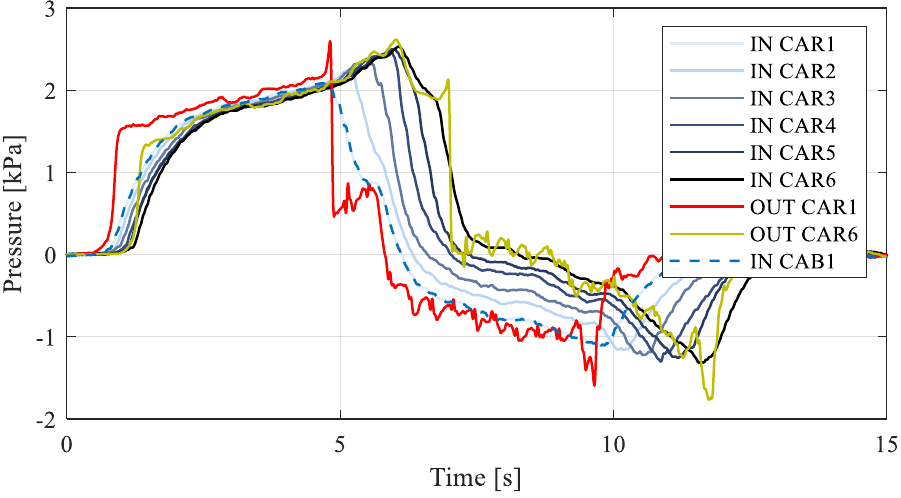
Figure 15. Comparison between the pressure acquired in different positions, outside and inside, along the sealed train ( a ) and the unsealed train ( b ).